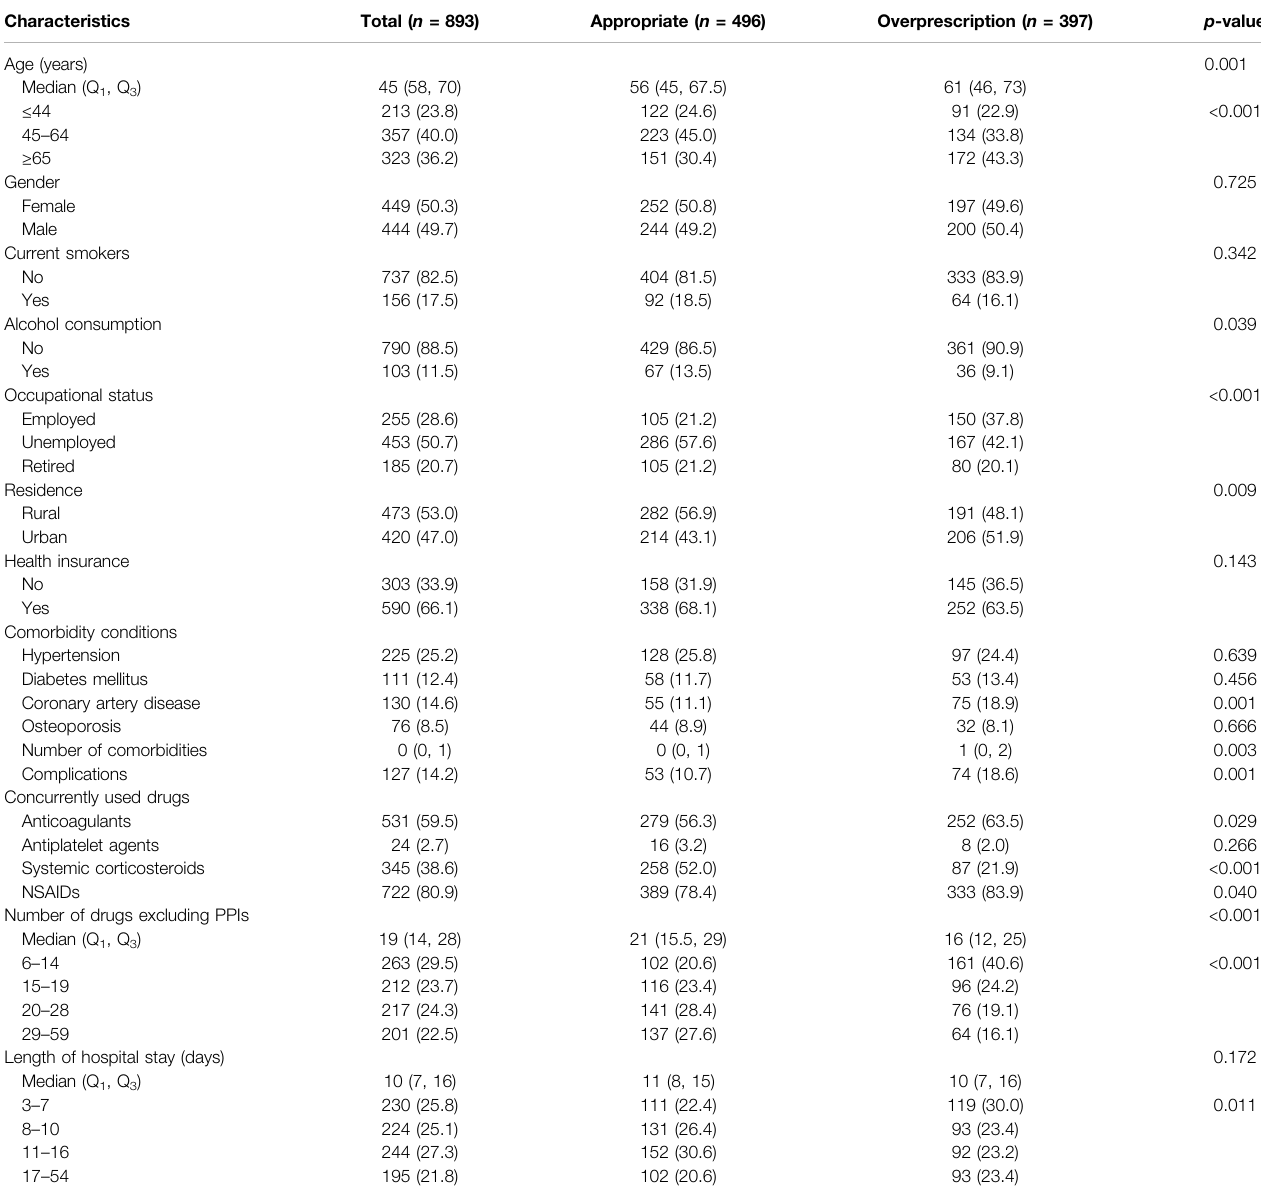
TABLE 5 | Demographic and clinical characteristics of inpatients with ASMs prescription for SUP.